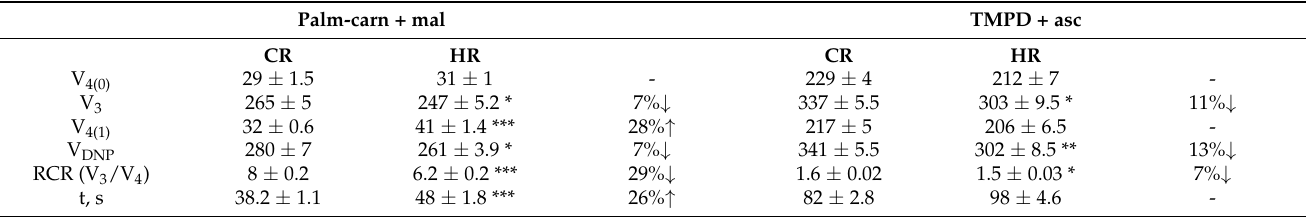
Table 3. Respiration parameters of heart mitochondria of control and hyperthyroid rats.